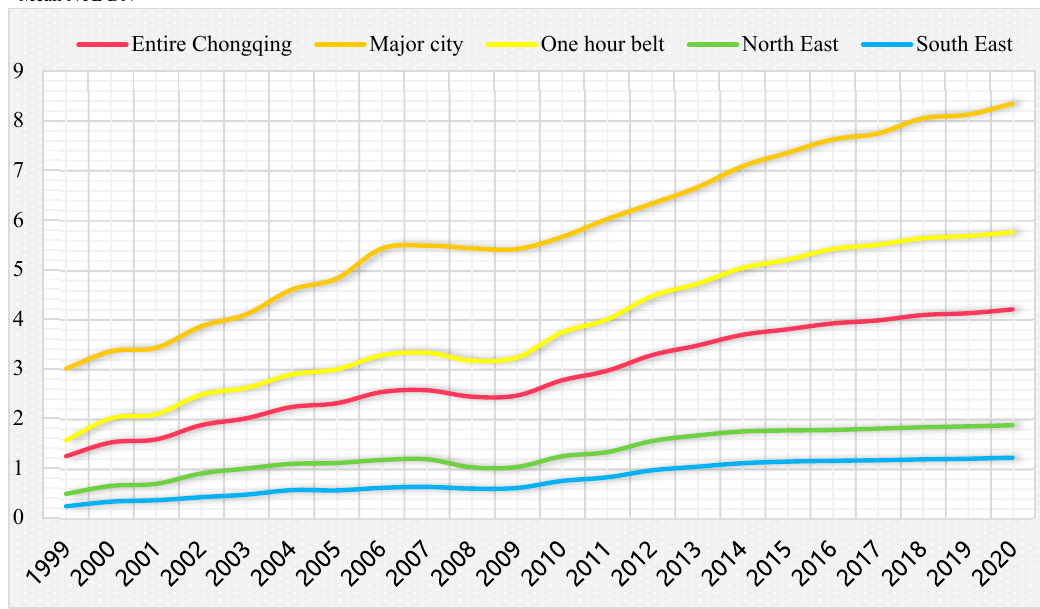
Figure 12. NTL mean from 1999 to 2020 for Chongqing and four sub-city regions.